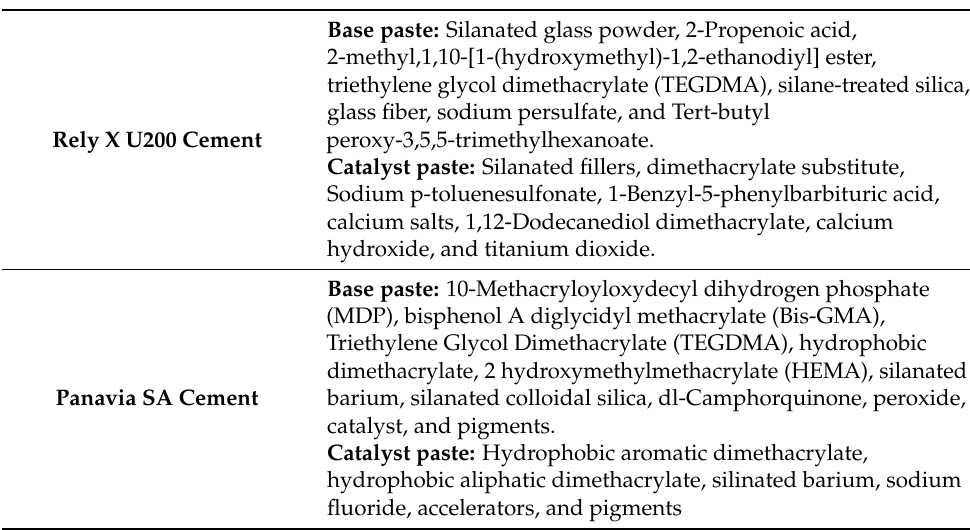
Table 1. Composition of self-adhesive resin